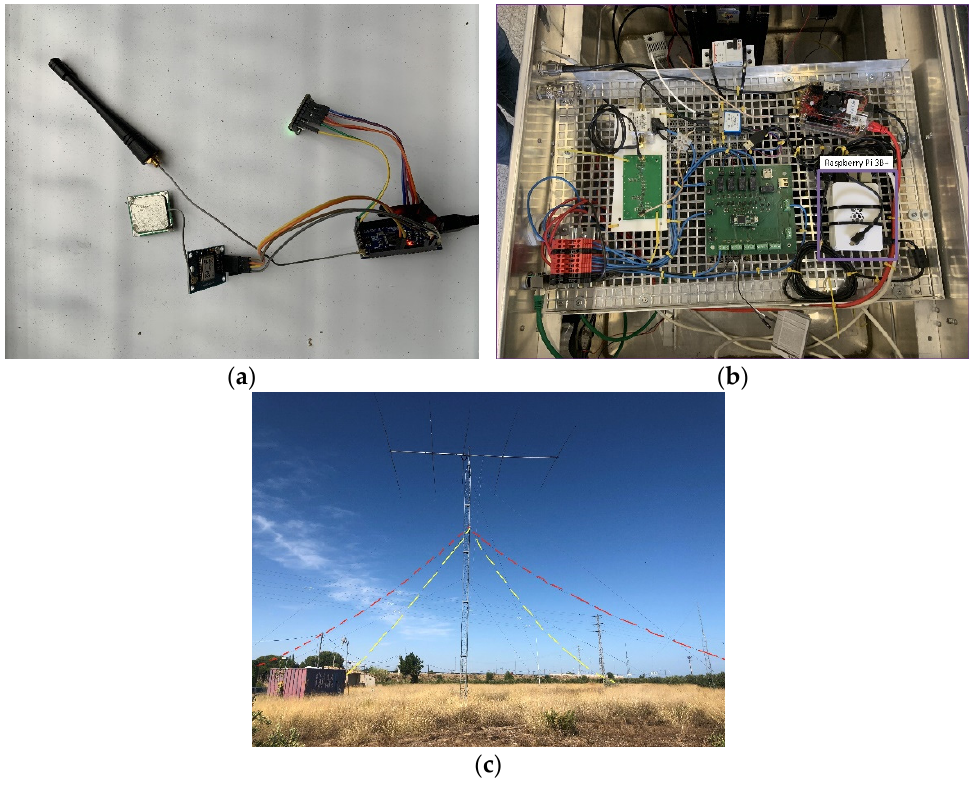
Figure 3. Antarctic WSN Hardware. ( a ) Moteino node with LoRa transceiver. ( b ) NVIS node with Raspberry Pi 3B+ gateway. ( c ) NVIS inverted vee antenna.